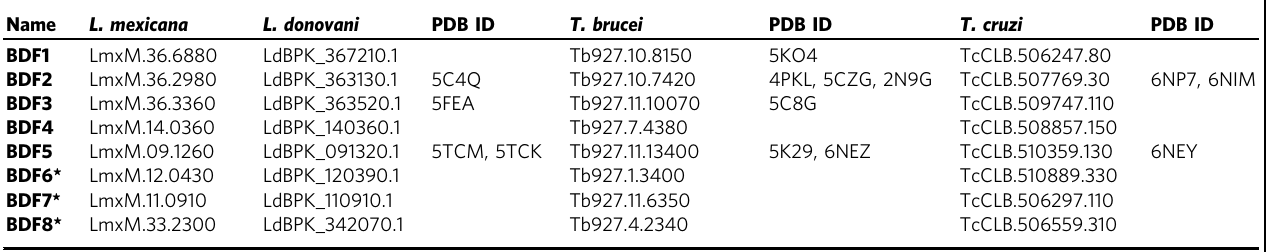
Table 1 Gene IDs for L. mexicana BDFs and orthologues in selected trypanosomatids.